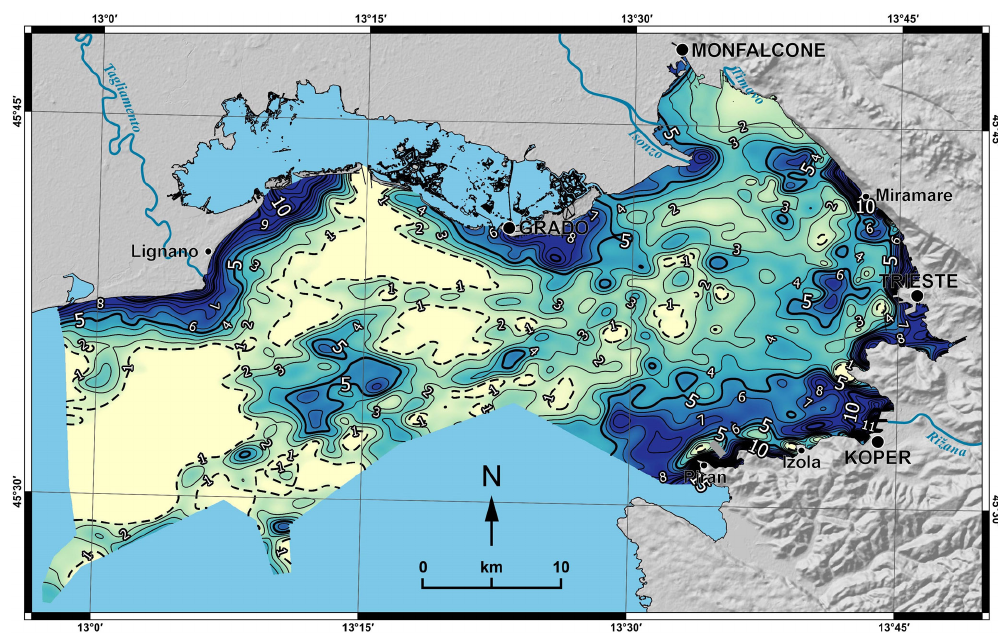
Figure 9. Map of the thickness of the Holocene marine sediment in metres. Dashed black lines mark areas where Holocene marine sediment is thinner than 1m or even